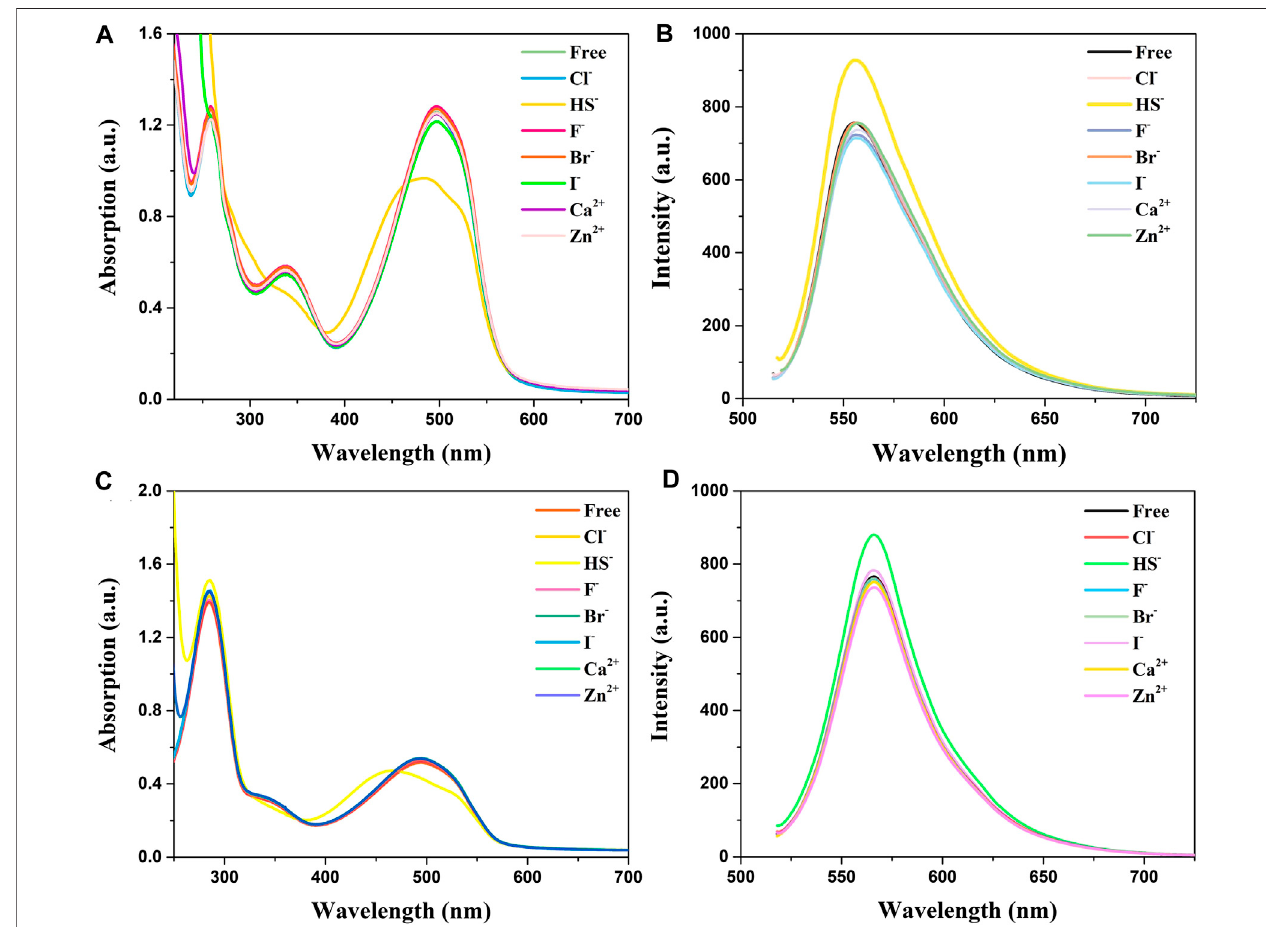
FIGURE 2 | Absorption and fl uorescence responses of probes to ions (100 μ M) in aqueous solution. (A) Absorption and (B) Fluorescence spectra of BDP-1 (10 μ M); (C) Absorption and (D) Fluorescence spectra of BDP-2 (10 μ M). (1) Free; (2) Cl − ; (3) NaHS; (4) F − ; (5) Br − ; (6) I − ; (7) Ca 2+ ; (8) Zn 2+ . Data were recorded 10 min after the addition of different